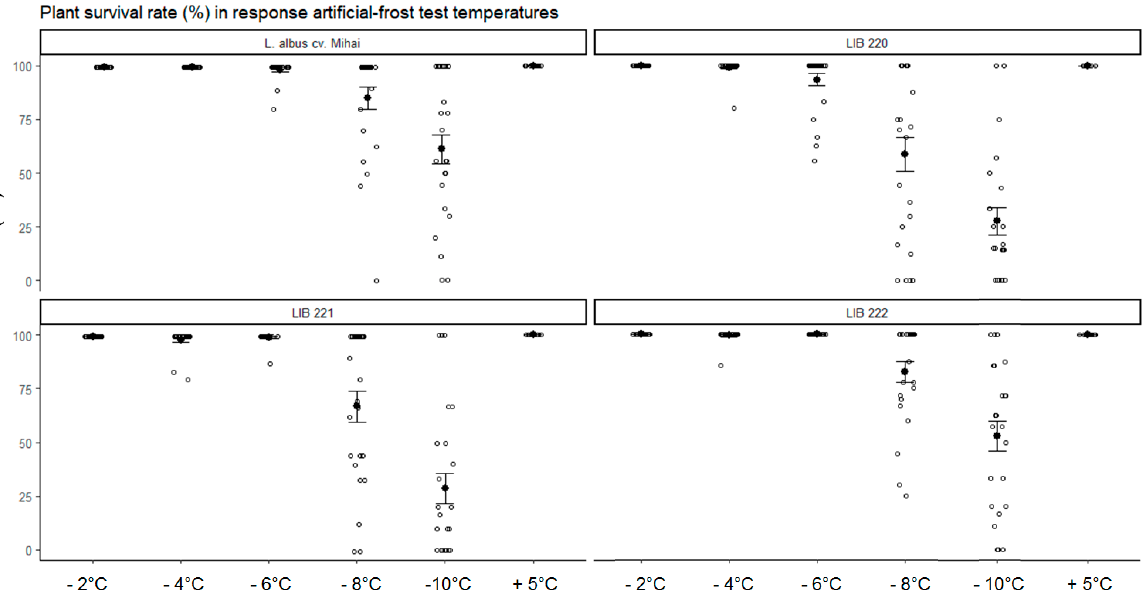
Figure 3. Assessment of four accessions, L. albus cv. Mihai and L. mutabilis LIB 220, LIB 221, and LIB 222 plant survival rate, in percentage, in response to artificial ‐ frost test temperatures ranging from low ( − 2 °C) to high ( − 10 °C) frost stress and with control samples at (+5 °C). Each dot represents the mean survival rate (%) of the 10 biological replicates, from one of the six containers, per genotype x temperature comparison, across all developmental phases.